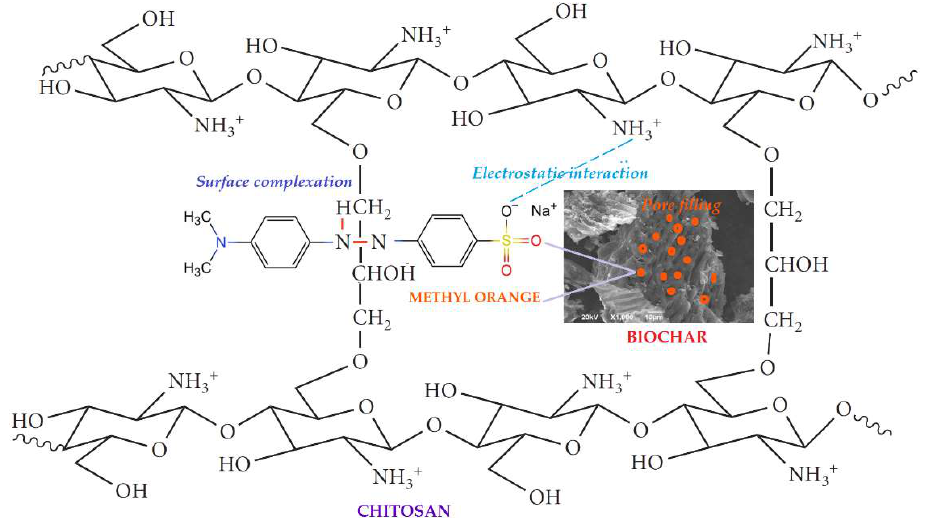
Figure 8. Possible chemisorption and diffusion mechanisms of MO onto CSBC hydrogel beads.